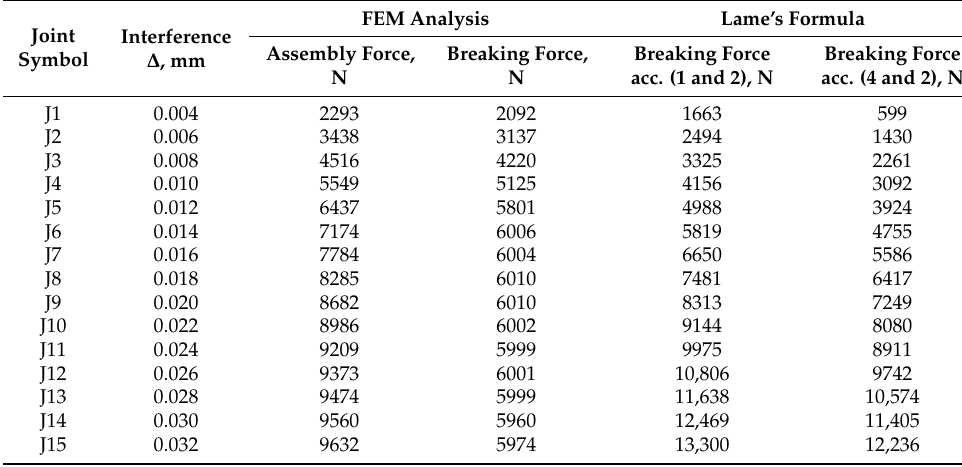
Figure 10. Graphs of assembly forces with marked breaking forces of the J1, J5, J10, and J15 joint. Table 4. Summary of assembly forces and breaking forces for each